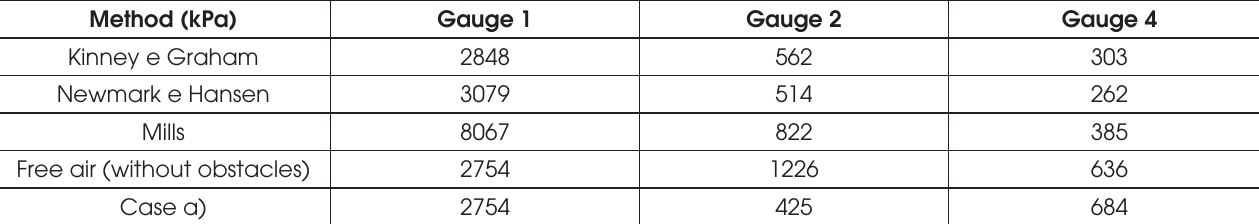
Comparison between numerical results and semi empirical